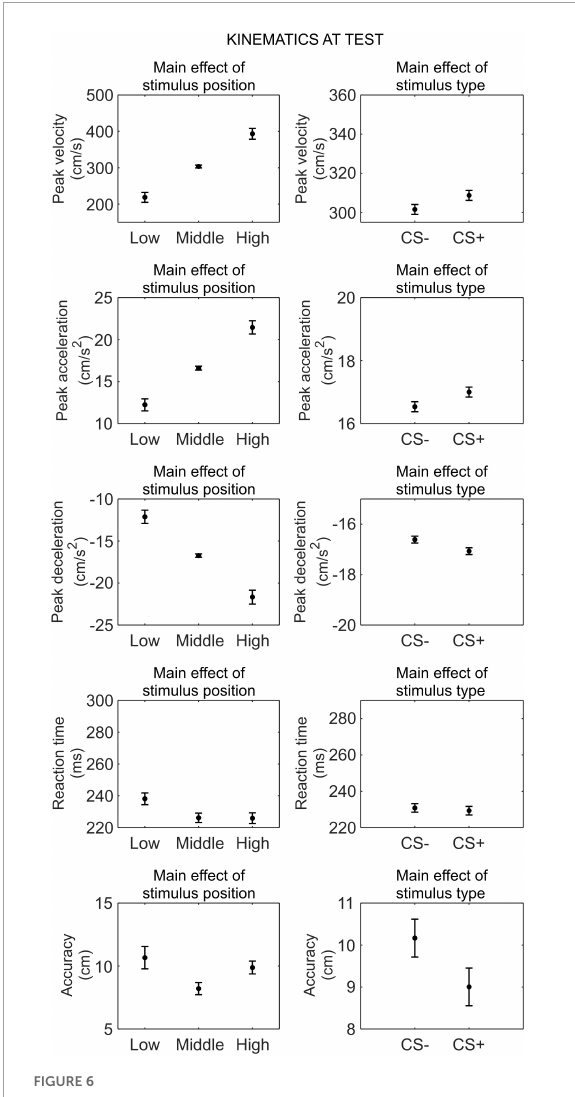
FIGURE6 Kinematics at test. Each plot shows the group mean (black dot) and 95% confidence intervals (vertical bars) of the different kinematic parameters as a function of the stimulus position or the stimulus type. 95% CI were corrected for within-subjects designs (Cousineau,